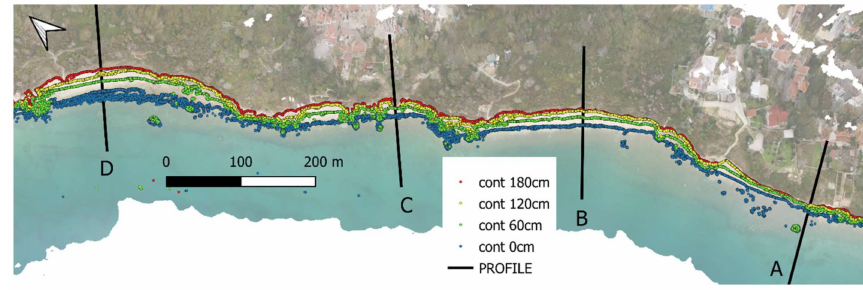
Figure 13. Coastal heights (0, 60, 20 and 130 cm) delivered from point